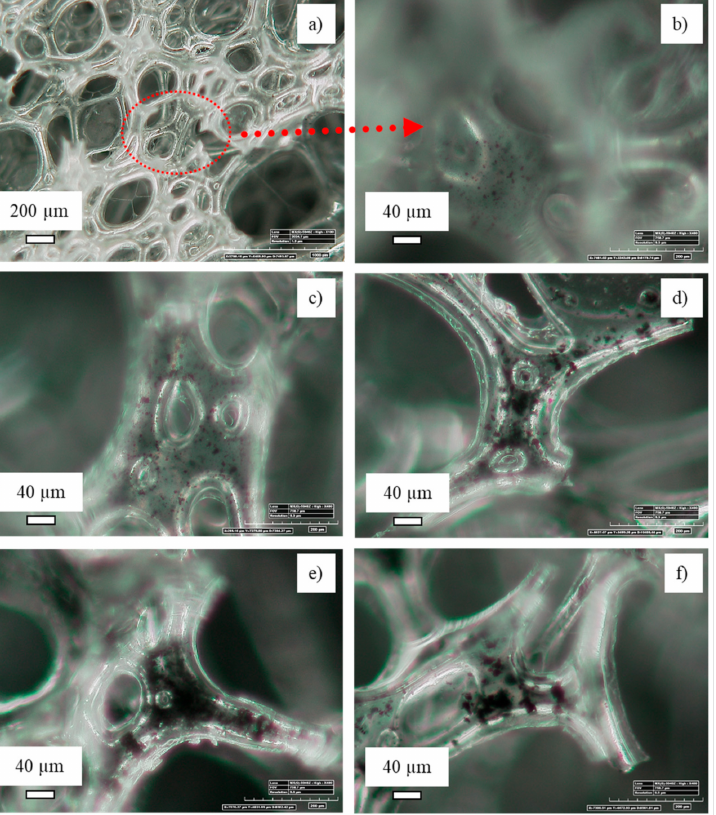
Figure 8. OM images of PUCNF0.5 at 100 × ( a ) and its magnification at 400 × ( b ); magnifications at 400 × of PUCNF1 ( c ), PUCNF3 ( d ), PUCNF5 ( e ), and PUCNF15 ( f